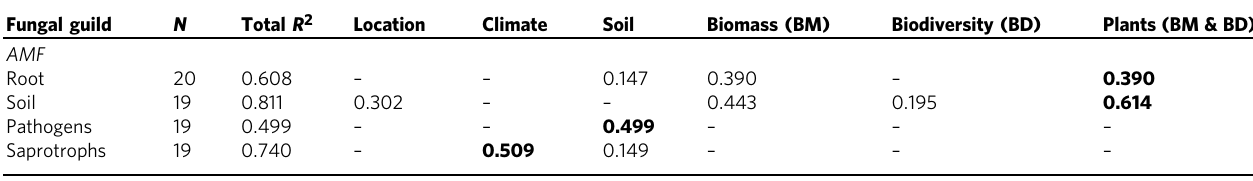
Table 1 Total variability ( R 2 ) explained from each fungal guild by the most parsimonious predictive model and amount of variability explained by predictor